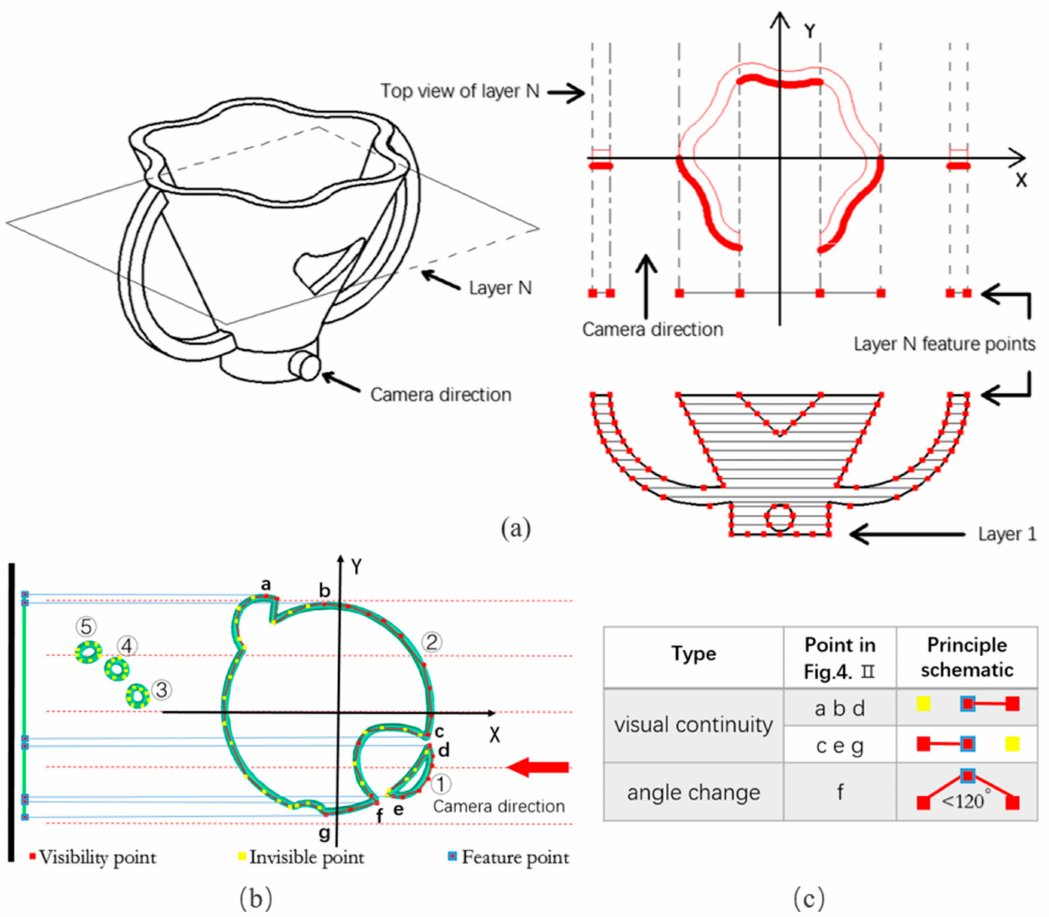
Figure 4. Self-feature extraction: ( a ) The specific process of self-feature extraction; ( b ) Extraction rules of visual points and feature points in current camera direction; ( c ) Three-point judgment of feature point.